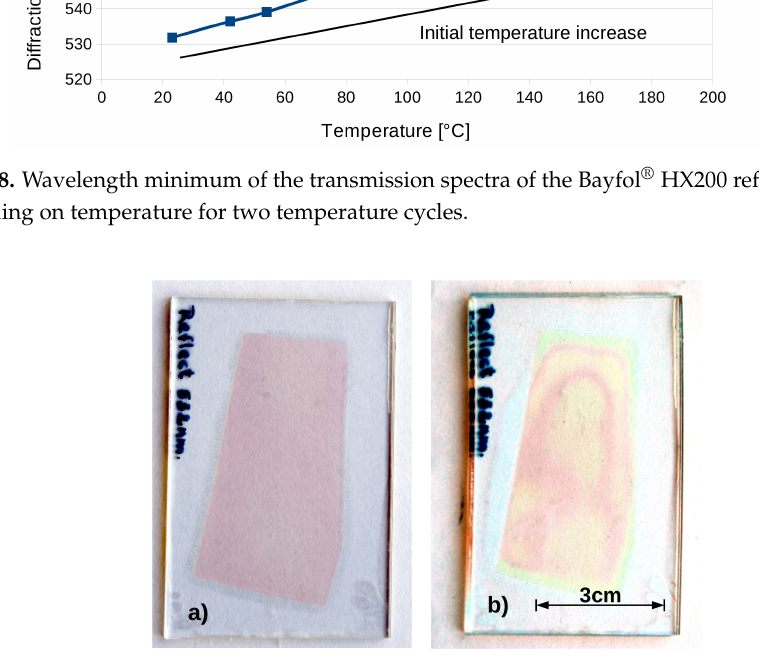
Figure 9. Pictures of the reflection hologram sample before thermal treatment ( a ) and after initial temperature increase from ambient temperature to 170 ◦ C ( b ). Note that the pink coloration of the sample was not due to the material absorption but to the diffraction of the green wavelength that was no more present in the transmission spectra (white light − green =